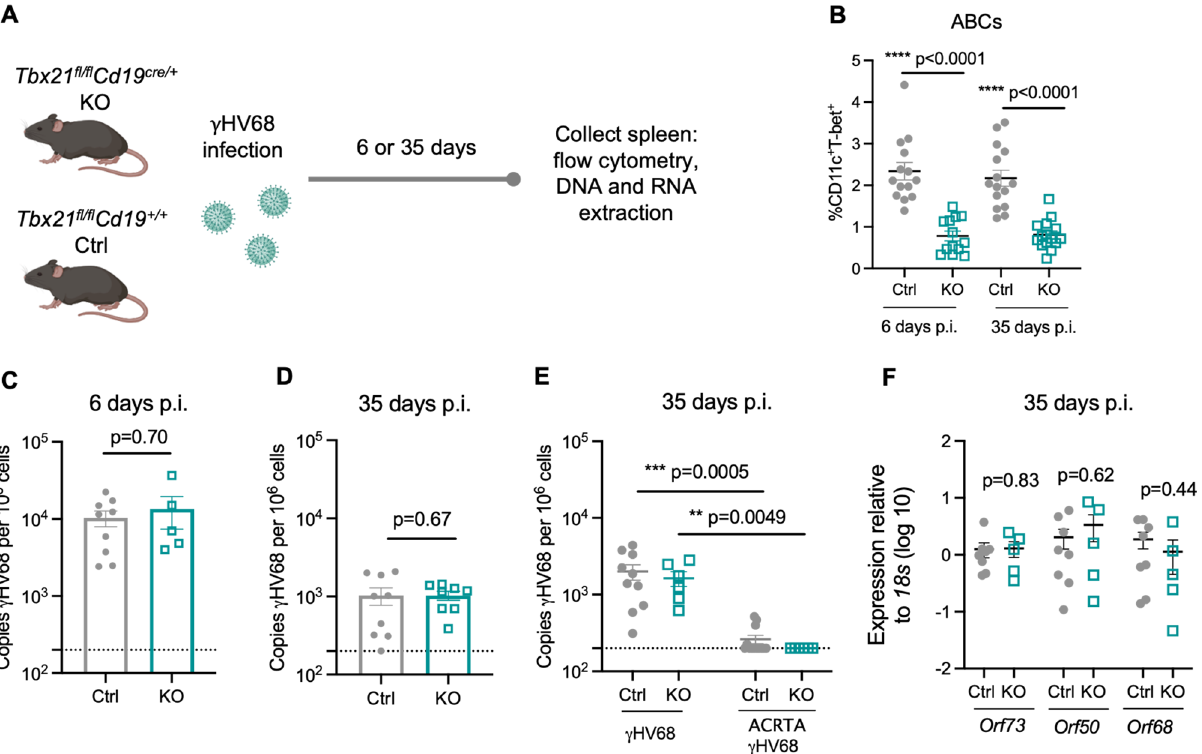
Figure 4. ABCs are not required for controlling lytic infection and achieving long-term latency. Tbx21 fl/fl Cd19 + / + (Ctrl, filled grey circles) and Tbx21 fl/fl Cd19 cre/ + (KO, open blue squares) mice were infected i.p. with γHV68 or ACRTA-γHV68. 6 or 35 days p.i., spleens collected and processed for RNA extraction, DNA extraction, and flow cytometry. ( A ) Experimental scheme for data shown in panels ( B–D,F ). ( B ) Proportion of ABCs (CD11c + T-bet + ) of previously activated B cells (CD19 + IgD − ) in the spleen in Ctrl and KO mice 6 and 35 days post-γHV68 infection. ( C,D ) Splenic γHV68 viral load (copies Orf50 per million cells) in Ctrl (filled circles) and KO (open squares) mice as determined by qPCR day 6 and 35 p.i., with limit of detection indicated by dotted line. ( E ) Splenic γHV68 viral load (copies Orf50 per million cells) in Ctrl and KO mice infected with γHV68 or ACRTA-γHV68 35 days p.i. ( F ) Relative expression in the spleen of Orf73 , Orf50 , and Orf68 in Ctrl and KO mice at day 35 p.i. Each data point represents an individual mouse. Both male and female mice were included in the experiments. Data presented as mean ± SEM, analyzed by Mann–Whitney test ( B–D,F ) or Kruskal–Wallis H test ( E